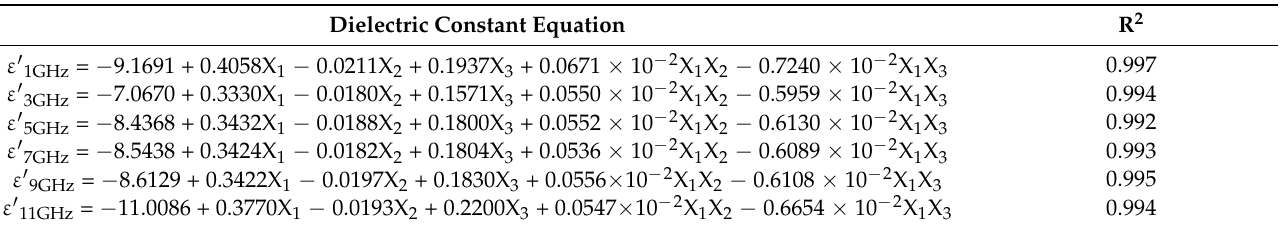
Table 1. Regression equations for the dielectric constant ( ε (cid:48) ) of the porous nHA/S composites at 1, 3, 5, 7, 9, and, 11 GHz.